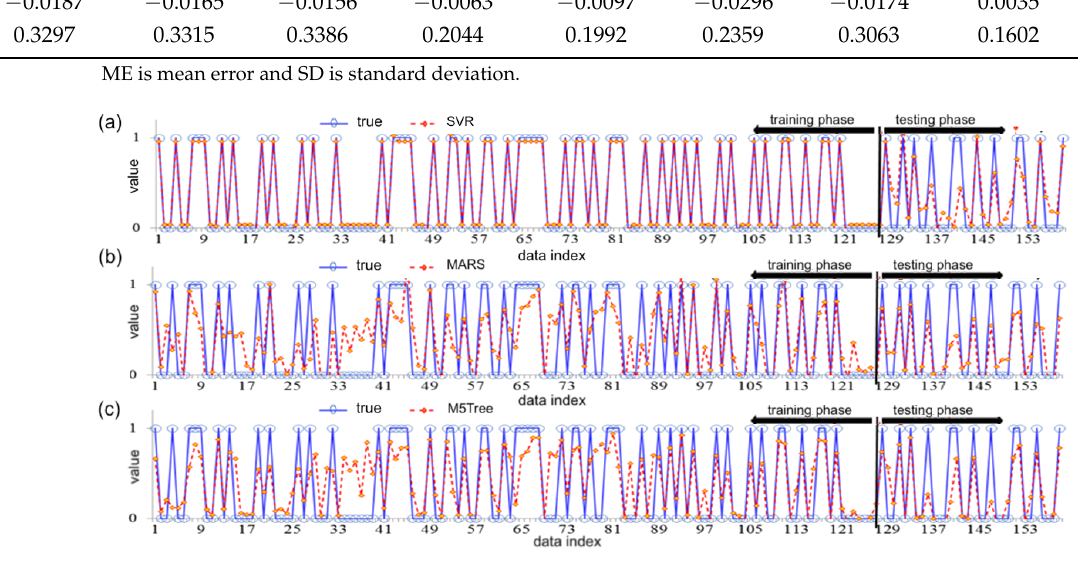
Figure 13. Plots of true data—blue—points used for the training and testing of the SVR ( a ), MARS ( b ) and M5Tree ( c ) methods and red points are the predicted outcomes; see abbreviations in